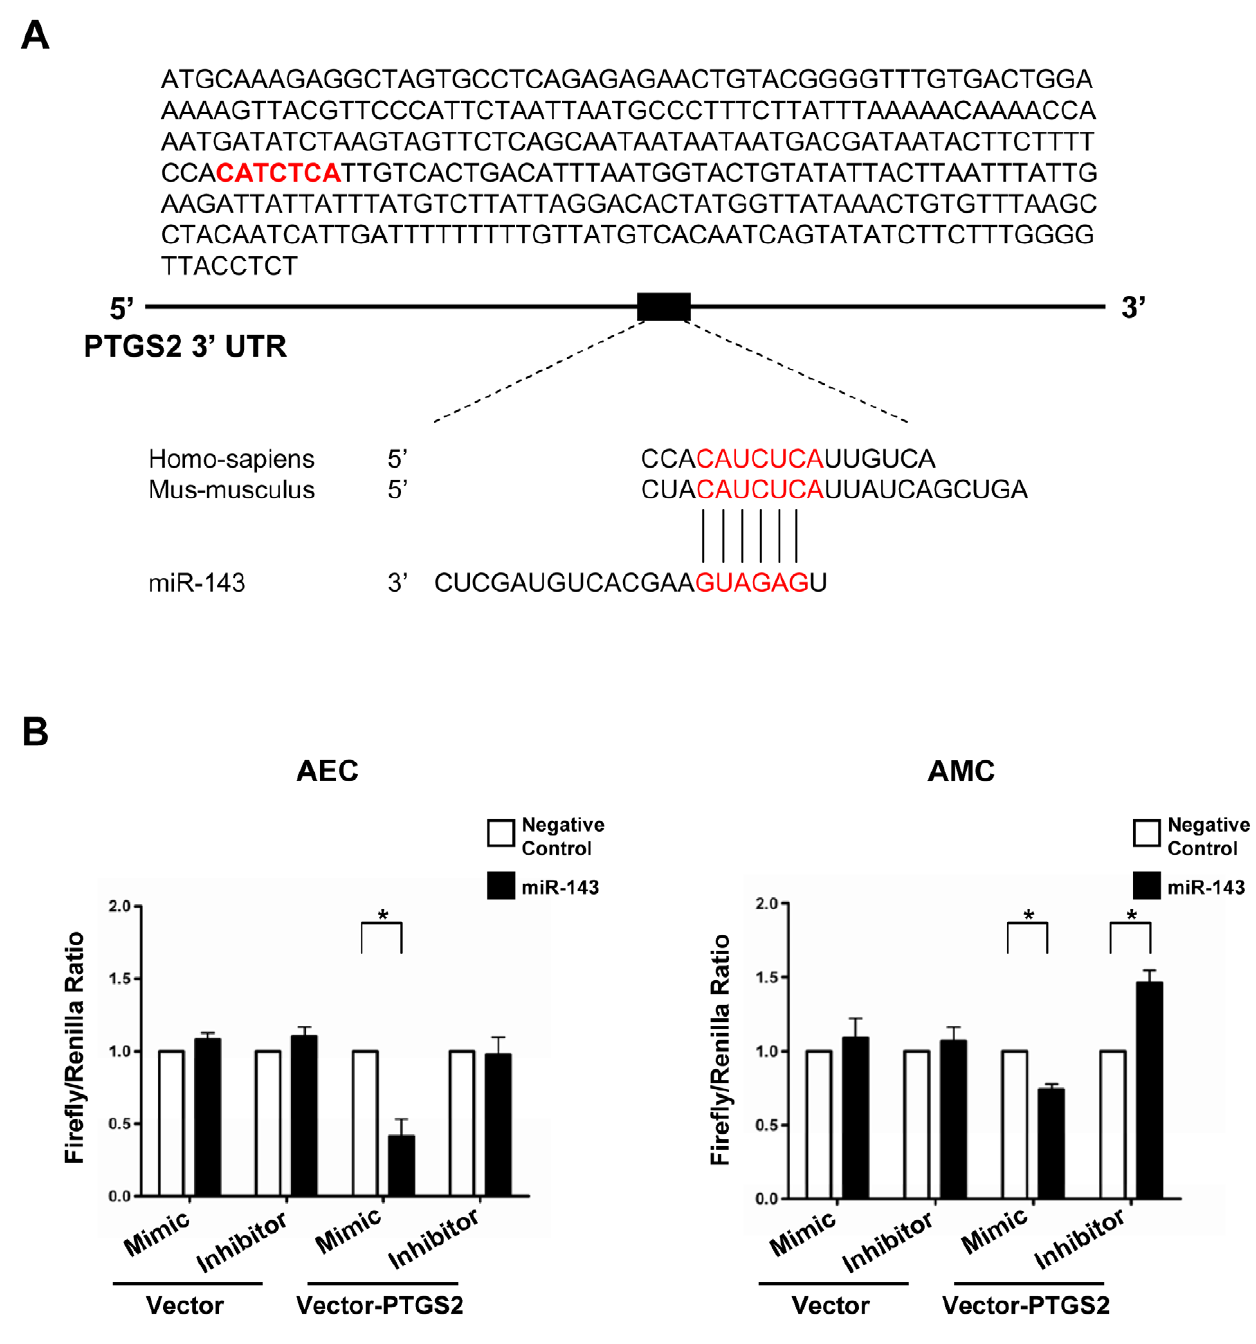
Figure 3. miR-143 binding to the 3 9 UTR of PTGS2 mRNA. A, Putative miR-143-binding site in 333 bp of PTGS2 3 9 UTR construct cloned into pMIR-REPORT TM for luciferase reporter assay. B, Luciferase reporter assay of PTGS2 mRNA 3 9 UTR in AECs and AMCs. Luciferase activities from AECs and AMCs transfected with 200 ng (AEC) or 500 ng (AMC) of luciferase reporter plasmid containing PTGS2 3 9 UTR (pMIR-REPORT_PTGS2), 10 ng of Renilla luciferase reporter pSV40-RL, and miRIDIAN miR-143 mimic (100 nM) or miR-143 hairpin inhibitor (50 nM) or equal amounts of negative controls were measured using Dual-Lucifrerase Reporter Assay System (Promega). pMIR-REPORT was used as a control. In AECs, there is a 58.5% of decrease in luciferase activity following transfection with miR-143 mimic but transfection of miR-143 hairpin inhibitor does not alter luciferase activity. In AMCs, miR-143 mimic transfection decreased luciferase activity by 25.9% compared to the control, while inhibition of miR-143 increased luciferase activity by 46.2% compared to control. Renilla luciferase activity was used for normalization of firefly luciferase activity (n=5). The graphs show means and SE. *, p , 0.05. doi:10.1371/journal.pone.0024131.g003 and decreased ( p =0.014 for both) the expression of miR-143, However, effects of miR-143 inhibitor transfection were minimal on respectively (Figure 4A). Consequently, PTGS2 protein expression miR-143 and PTGS2 expressions, which were consistent with the was decreased upon miR-143 mimic transfection, and inhibition of luciferase reporter assay data (Figure 4A and 4B). In AMCs, miR- miR-143 increased PTGS2 expression ( p =0.014; Figure 4B). 143 mimic and hairpin inhibitor transfections significantly increased